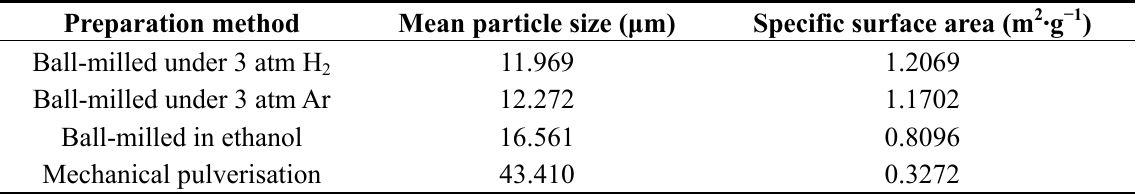
Table 1. Mean particle size and specific surface area of the mechanically pulverized hydrogen storage alloy (HSA) and of the HSAs ball-milled in different media.